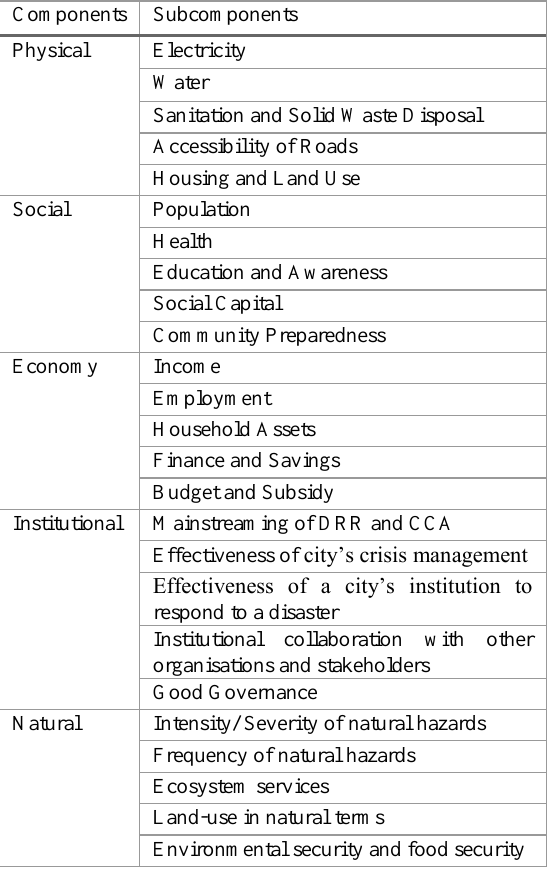
Table 1: Components and sub-components of CDRI. Source: Shaw et al.